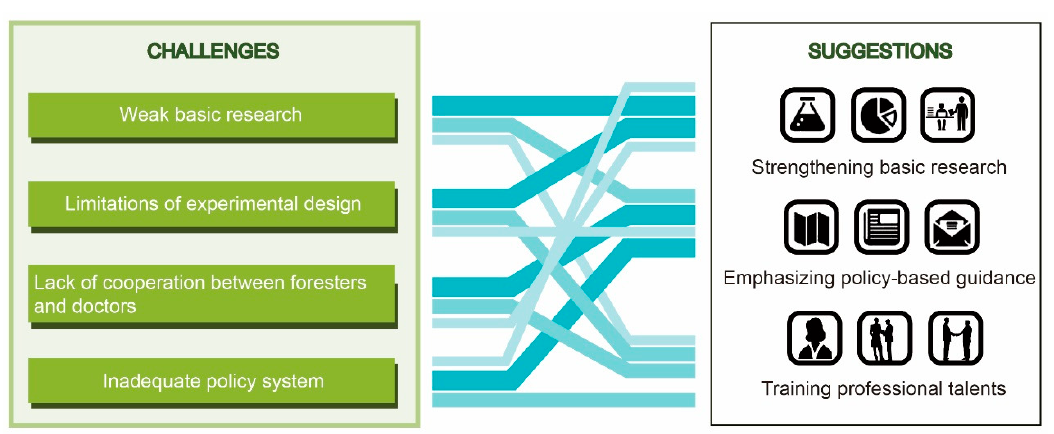
Figure 2. Challenges and suggestions for the development of forest therapy.